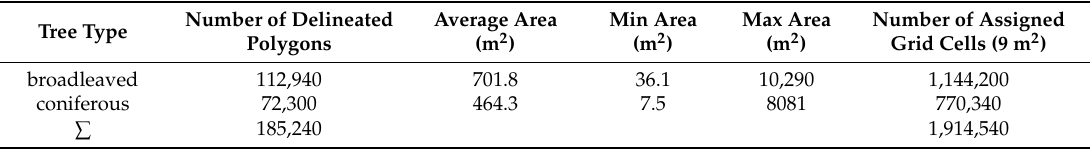
Table 2. Tree types sampled. The number of polygons refers to the delineated reference polygons, whereas the number of assigned grid cells refers to the corresponding grid cells in the 3-m regular